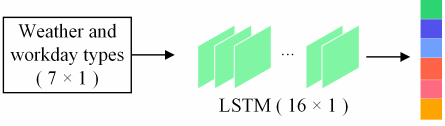
Figure 6. The LSTM network